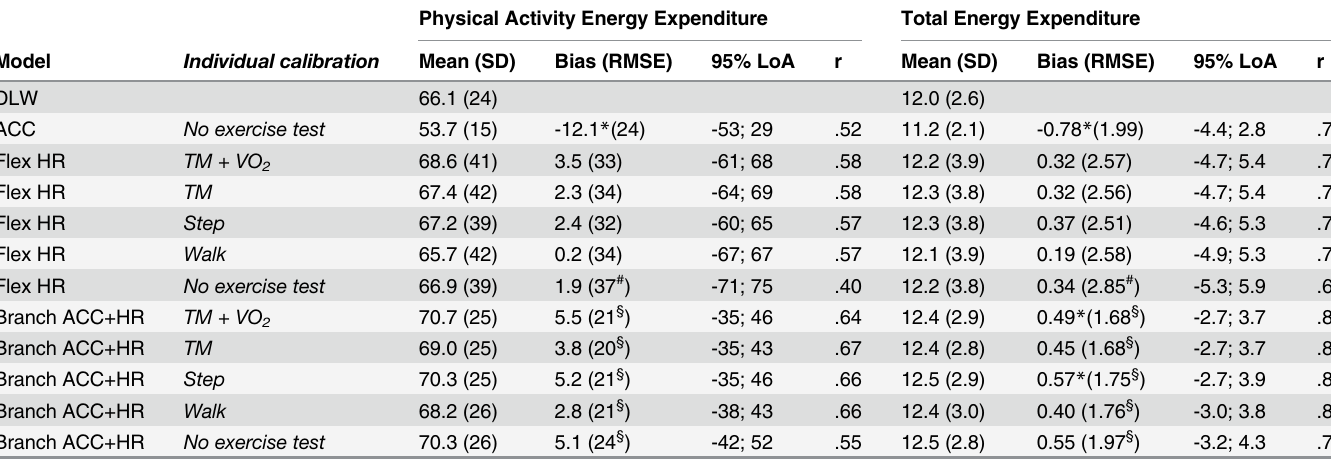
Table 2. Validity of ACC-, HR-, and combined ACC+HR equations for predicting Energy